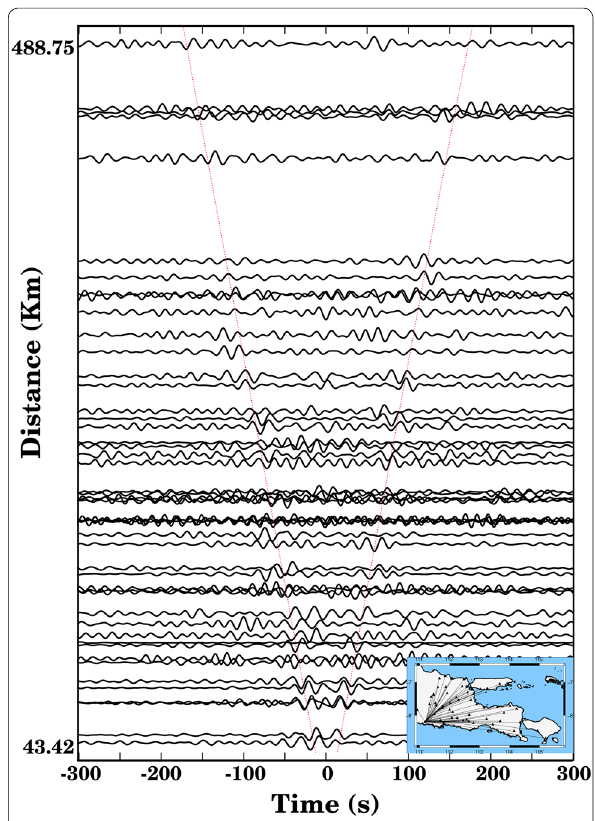
Fig. 3 Rayleigh wave Green’s functions between a permanent station (PCJI) on the southwestern edge of the network and other stations. Waveforms were filtered between 0.08 and 0.3 Hz. The time length of cross-correlation starts from 0 to 300 s. Red lines show group veloci- ties of 3